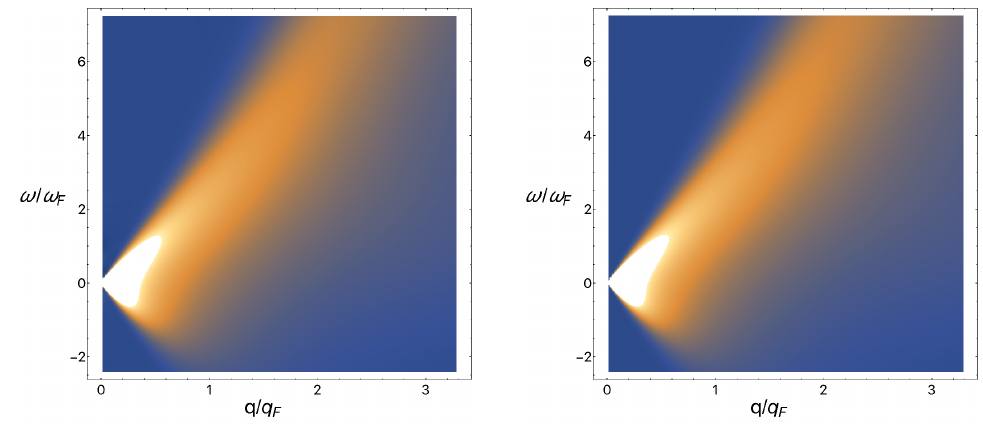
Figure 5: Left panel: DSF S ( q , ω ) as a function of q and ω for a thermal state at inverse temperature β = 1, D = 0.38 and c = 4. Right panel: Same for the one particle-hole contribution S ( 1 ) ( q , ω ) . The color scale is the same for both plots.